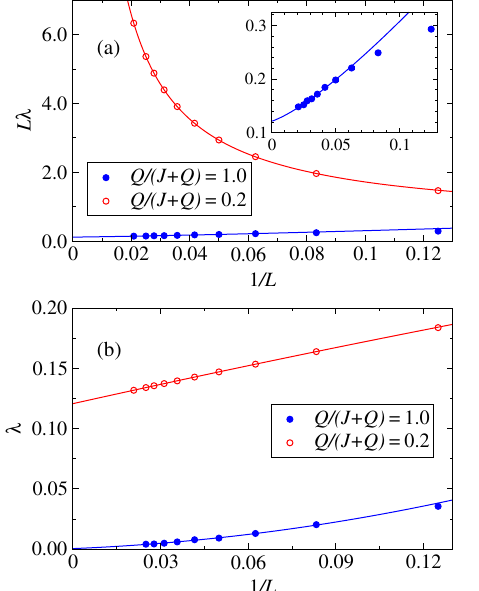
FIG. 10. Finite-size scaling properties of the string fraction λ of the random- Q model in the AFM state at Q= ð J þ Q Þ ¼ 0 . 2 and deep in the RS phase at Q= ð J þ Q Þ ¼ 1 . In (a), λ is scaled by L to demonstrate λ ∝ L − 1 in the RS phase (the inset shows the results on a more detailed scale). The results in (b) illustrate the expected size-independent string fraction in the AFM phase. Error bars are smaller than the symbols.